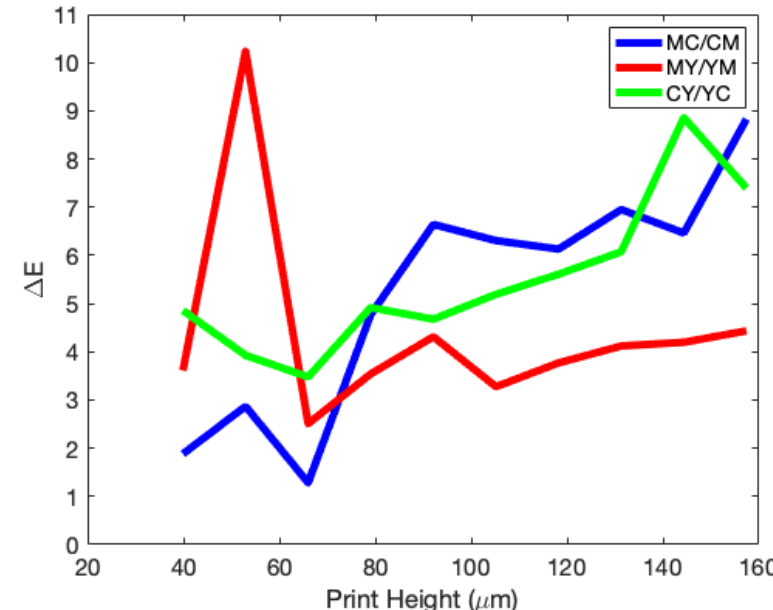
Figure 8. ∆ E ∗ values, the degree of difference between two prints, at each step height for the three second-order colours (RGB), when swapping the printing order (e.g., CM ←→ MC ). If ∆ E is larger than one, then the two prints are perceptively